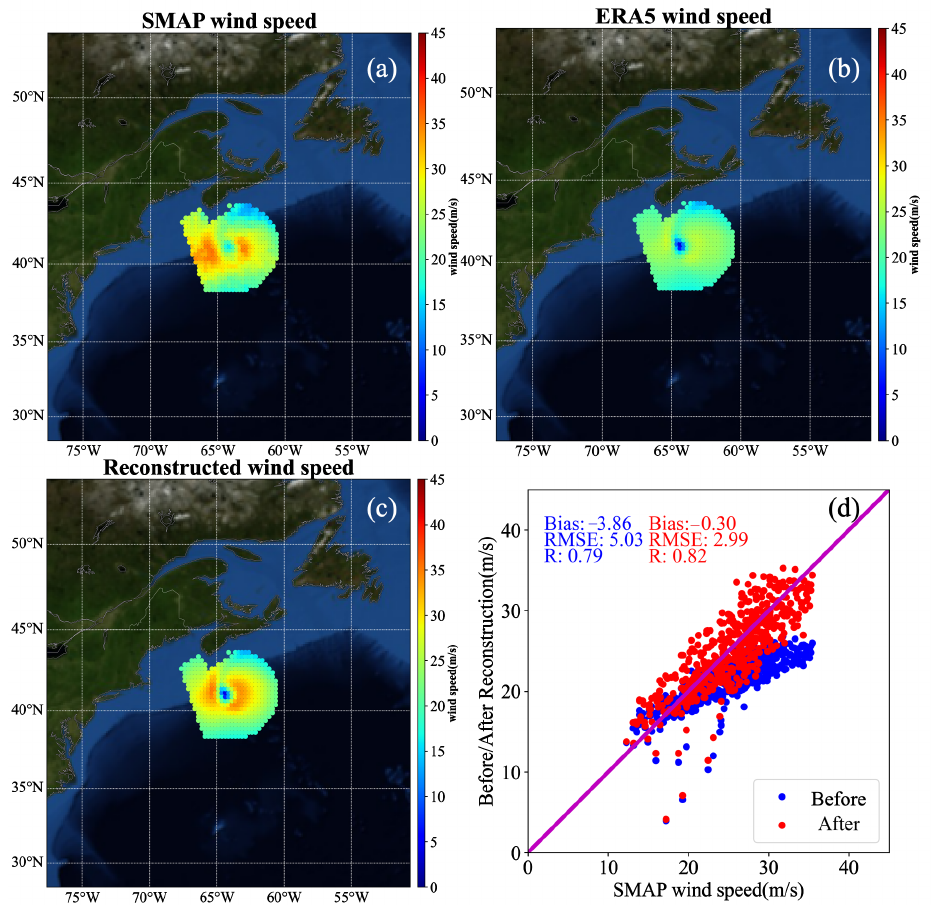
Figure 10. Wind distribution of Hurricane Teddy at 21:00 (UTC) 22 September 2020 in SMAP ( a ) and collocated with the before ( b ) and after ( c ) reconstructed wind speed within four times RMW based on the proposed method. ( d ) Scatterplot and statistics for the before (blue scatters) and after (red scatters) reconstructed wind speed versus the collocated SMAP high wind speed at 21:00 (UTC) 22 September 2020 during Hurricane